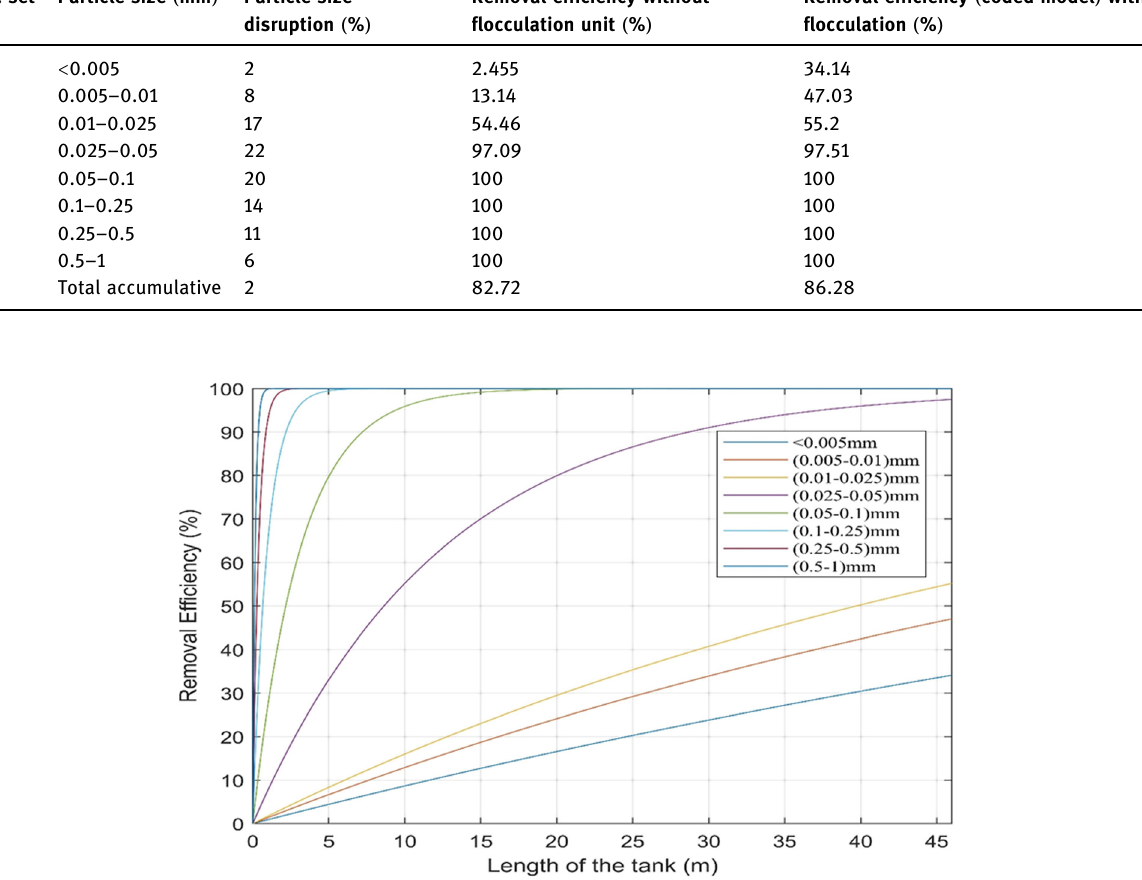
Figure 6: Removal e ffi ciency for each particle size of AL - Muthana sedimentation unit with fl occulation process.